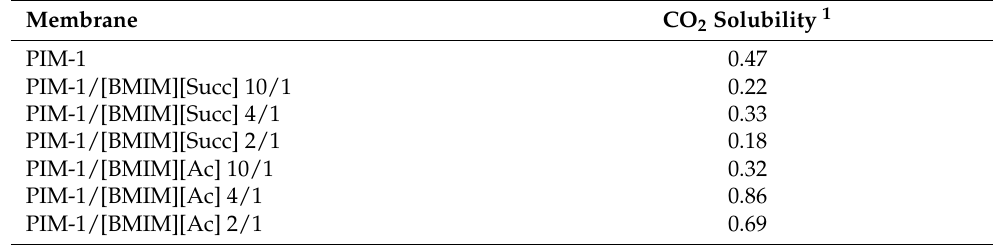
Figure 5. CO 2 solubility of blended membranes at four different CO 2 pressure of 0.2, 0.4, 0.6, 0.8 bar of [BMIM][Succ] ( a ) and [BMIM][Ac] ( b ). Table 1. CO 2 Solubility coefficients at 0.8 bar pressure derived from the direct sorption experiments. Membrane CO 2 Solubility